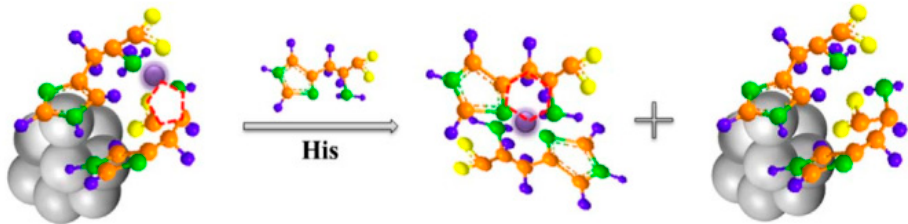
Figure 11. Schematic illustration of the coordination interaction of histidine (His)-AuNC with Cu 2 + , and His with Cu 2 + . Adapted with permission from Reference [84] Copyright (2017) Elsevier.